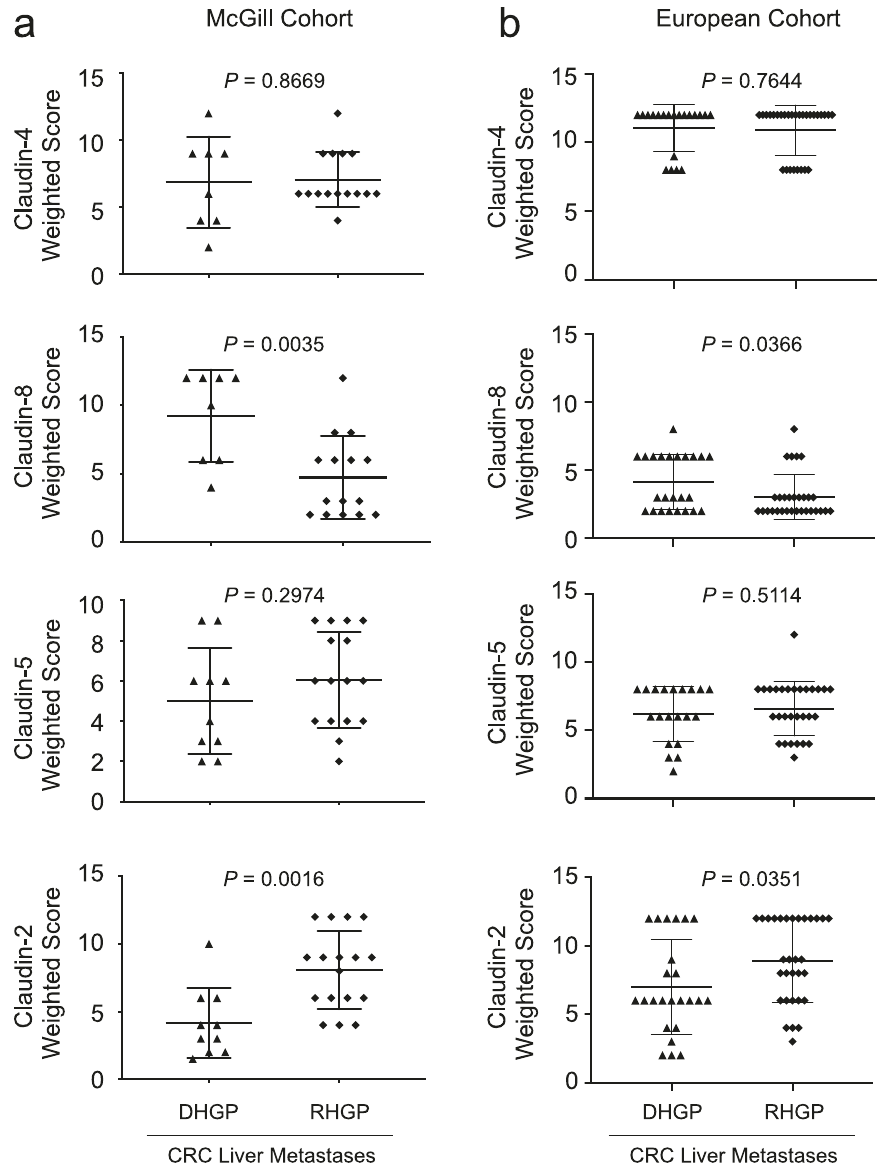
Fig. 3 Claudin-2 protein is enriched in the replacement-type lesions while higher Claudin-8 expression is associated with desmoplastic-type liver metastases. a, b Paraf fi n embedded sections from colorectal liver specimens were subjected to immunohistochemical staining with anti-Claudin-4, anti- Claudin-8, anti-Claudin-5, or anti-Claudin-2 antibodies in both the McGill ( a ) or European ( b ) cohorts. Claudin-8 expression is enriched in the desmoplastic-type lesions (DHGP). In contrast, Claudin-2 expression is increased in the replacement-type liver metastases (RHGP). Scoring of IHC staining was performed by two independent pathologists (AO, GA). Data are presented as the mean ±